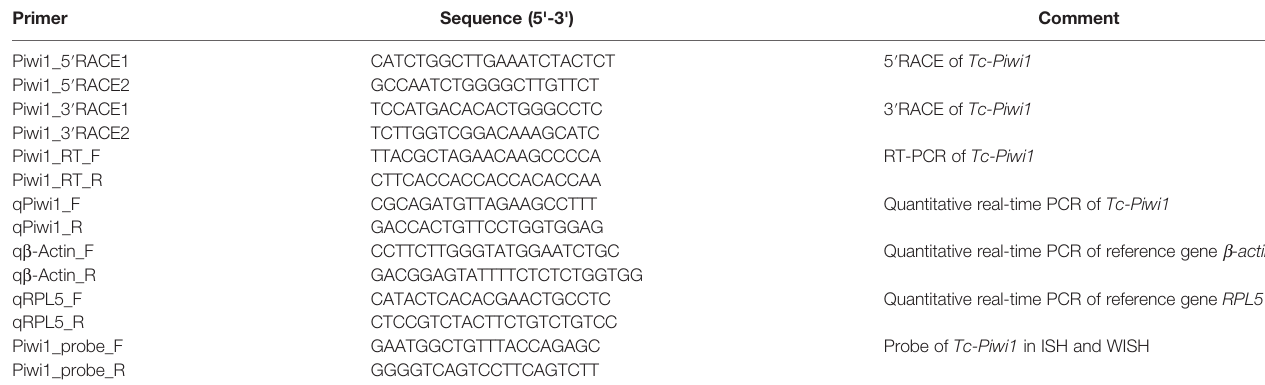
TABLE 1 | Sequences of primers used in this